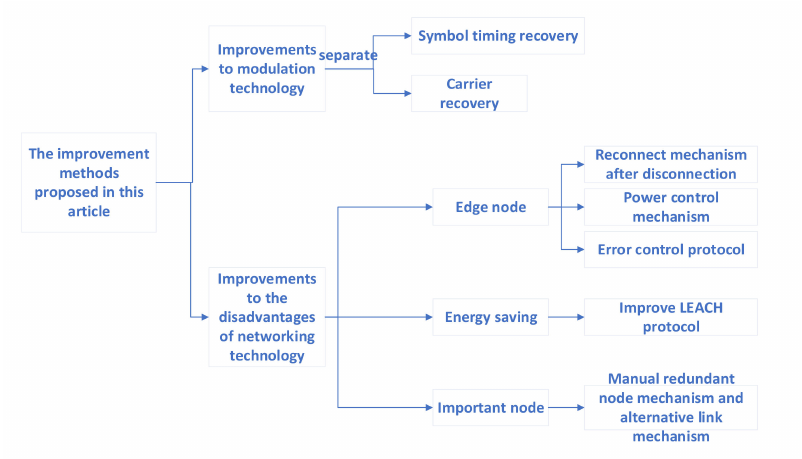
Figure 1. The main work of the